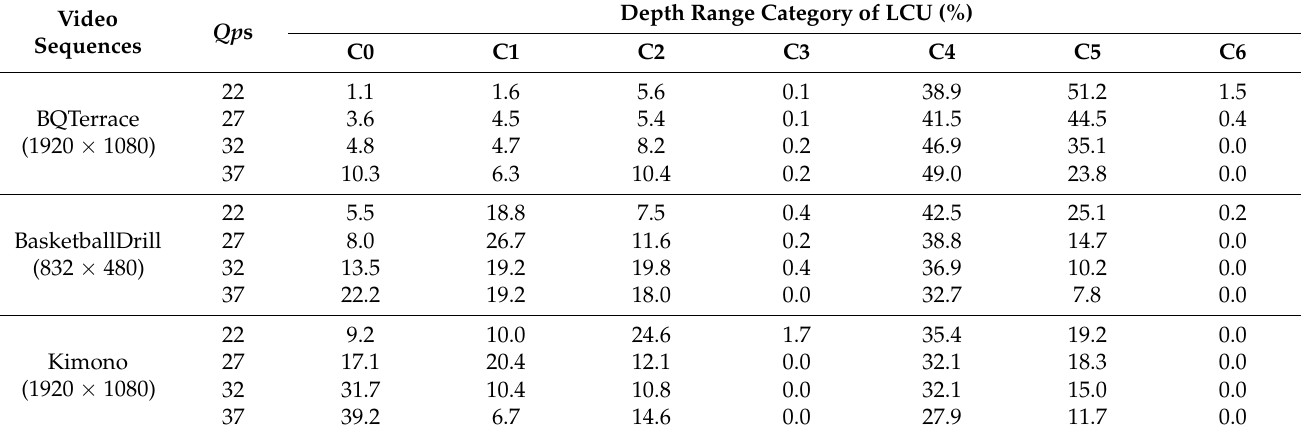
Table 2. Depth range class distribution (%).